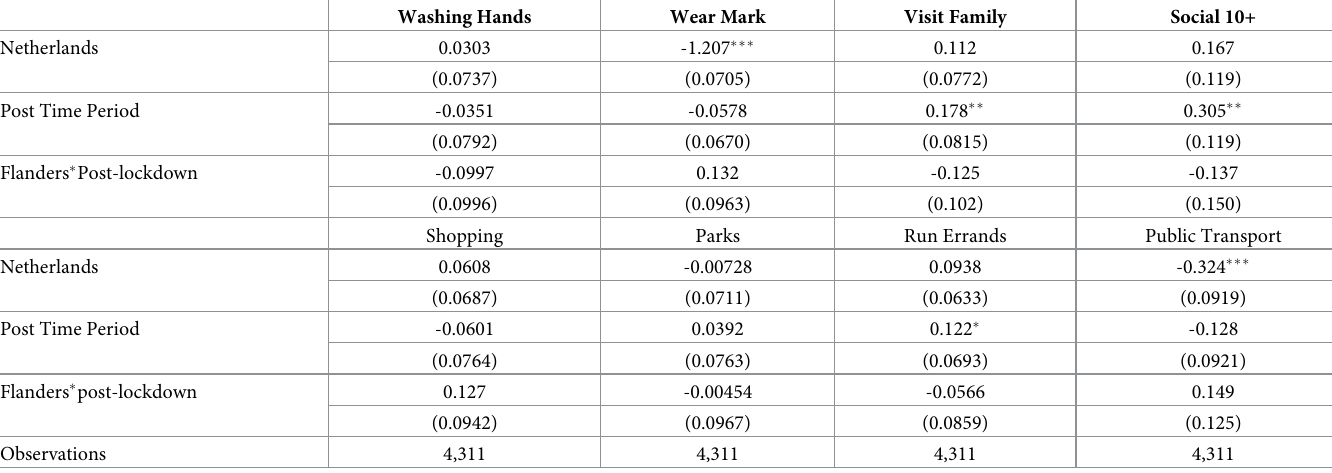
Table 4. The effect of policy changes on behavior (Private).